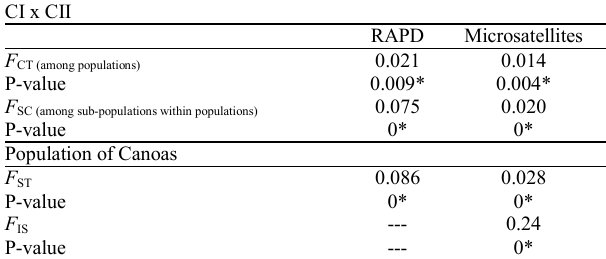
Table 3. Fixation index obtained by AMOVA for markers, RAPD and microsatellites, for the groups of Leporinus elongatus from the fish passage ladders of HEPs Canoas I and Canoas II- Paranapanema River. * = Statistically significant value to